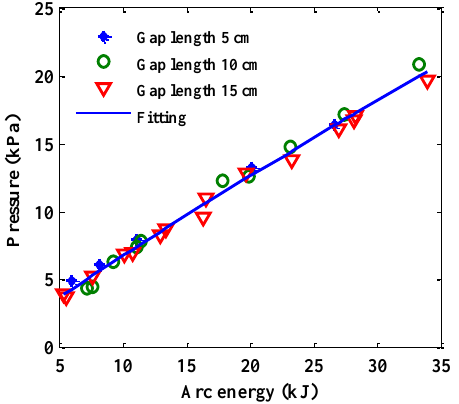
Figure 12. Change of the pressure rise with arc energy under different gap lengths.